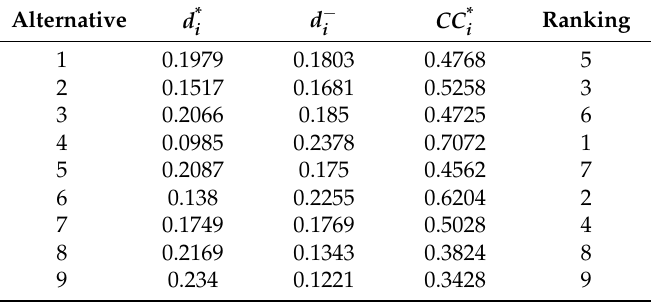
Table 7. Ranking of the nine alternative structural configurations obtained by the proposed heterogeneous technique for order preference by similarity to an ideal solution